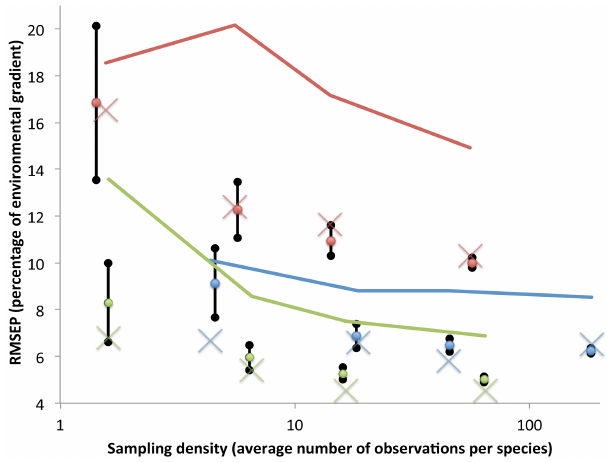
Figure 2. Application to artificial data. Reconstruction performance plotted against the sampling density (the average number of obser- vations per species in the training set). Colour indicates assemblage type: low richness and high tolerance (red), high richness and high tolerance (blue) or low richness and low tolerance (green). Circles with error bars are the mean and standard deviation of the WAPLS1 leave-one-out RMSEP calculated across an ensemble of artificial training sets. From each artificial ensemble, a member is selected that has a WAPLS1 error equal to the ensemble mean. BUMPER is applied to this training set; crosses are the BUMPER leave-one-out RMSEP, solid lines are the BUMPER uncertainty. In summary (see Sect. 3.2), this plot demonstrates the following: (1) reconstruction errors of WAPLS1 (circles) and BUMPER (crosses) are similar for all assemblages. (2) Increasing the sampling density of a training set reduces both the reconstruction errors (circles and crosses) and the BUMPER reconstruction uncertainty (solid lines). However, contin- ued benefits beyond a sampling density of ∼ 10 are modest. (3) Re- constructions from assemblages that benefit neither from high rich- ness nor from low tolerances (high taxon turnover), plotted in red, are associated with significantly greater error and reconstruction un- certainty. We note that the overstatement of BUMPER uncertainty relative to the reconstruction error (solid lines compared to crosses) is expected for this application to idealized data (see Sect.